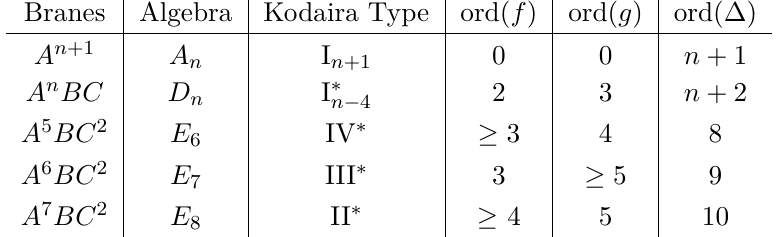
Table 2 . Vanishing orders for a Weierstrass model y 2 = x 3 + fxz 4 + gz 6 with discriminant ∆ = 4 f 3 + 27 g 2 realising the ADE brane configurations of table 1 as singularities in the fiber according to the Kodaira